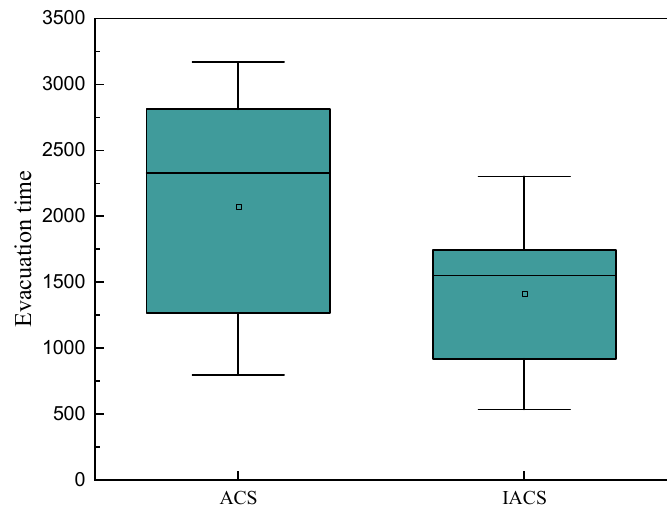
Figure 13. Comparison of the ant colony system (ACS) and IACS. Table 4. Comparison of ACS and